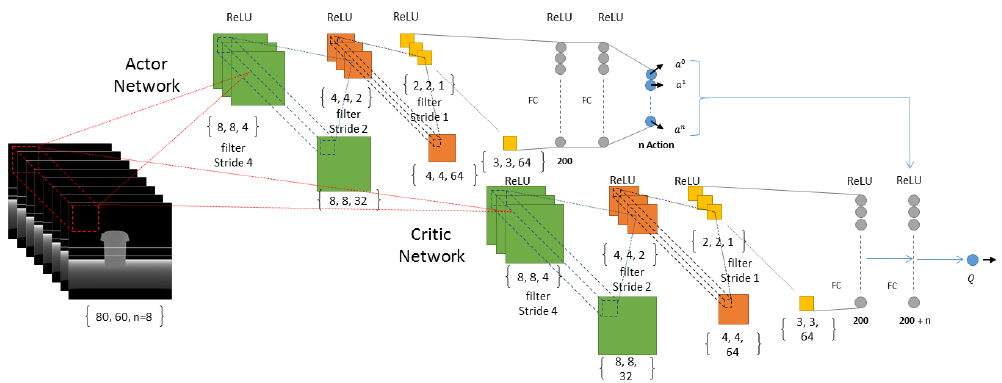
Figure 5. The deep Actor-Critic architecture used as a function approximator in our deep reinforcement learning regarding Continuous-Action type by changing the DDPG ([16]) architecture slightly to suit our input and short-term memory